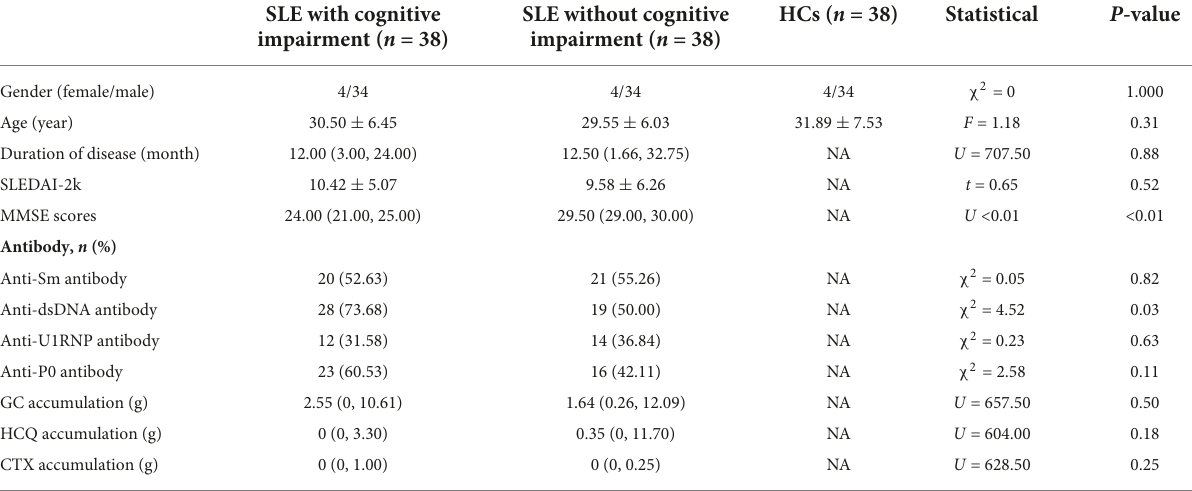
TABLE 1 Results of demographic and clinical data of SLE patients with cognitive impairment group, SLE patients without cognitive impairment, and healthy controls. SLE with cognitive SLE without cognitive impairment ( n = 38) impairment ( n =